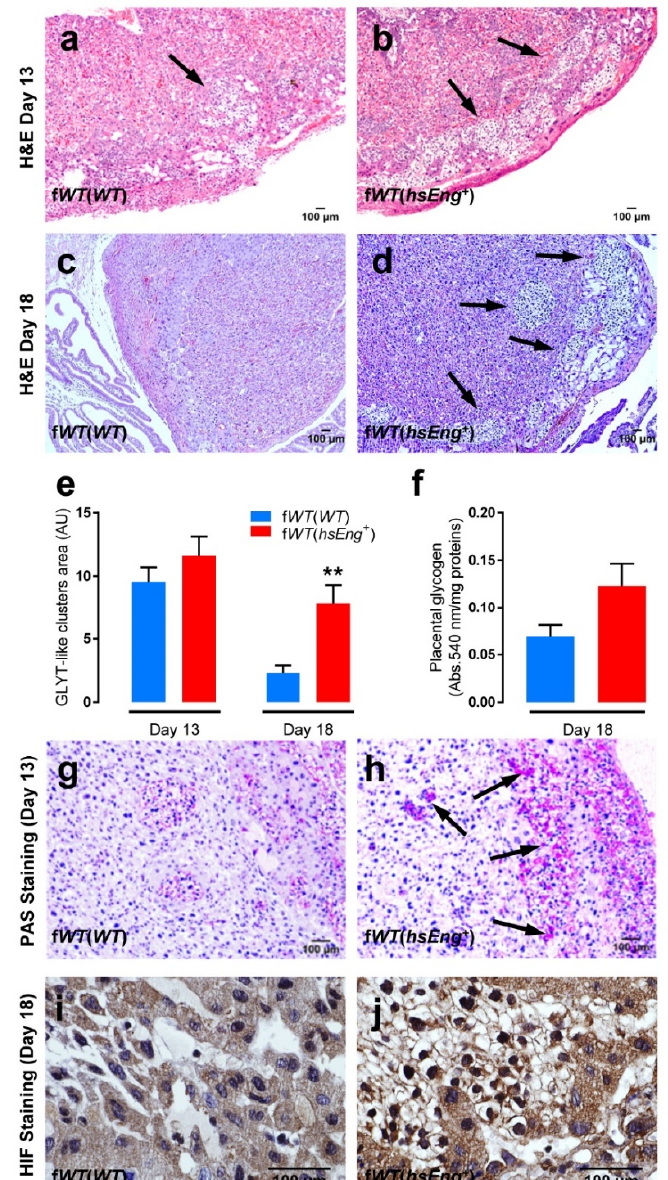
Figure 4. Histological alterations of placentas from f WT ( hsEng + ) mice. ( a – d ) Hematoxylin-eosin (H&E) staining of placentas from f WT ( WT ) and f WT ( hsEng + ) mice at Day 13 ( a , b ) and Day 18 ( c , d ) showing the presence of clusters of glycogen-containing trophoblast (GLYT)-like cells in the basal area of some placentas (arrows); ( e ) Quantification of the area occupied by GLYT-like clusters in placentas from f WT ( WT ) and f WT ( hsEng + ) mice at Day 13 (f WT ( WT ) n = 20 and f WT ( hsEng + ) n = 17) and Day 18 (f WT ( WT ) n = 13 and f WT ( hsEng + ) n = 16) of gestation; ( f ) Glycogen content in placentas from f WT ( WT ) ( n = 13) and f WT ( hsEng + ) ( n = 15) mice at Day 18 of gestation; ( g , h ) Periodic acid–Schiff (PAS) staining of placentas from f WT ( WT ) and f WT ( hsEng + ) mice at Day 18 colocalizing high levels of polysaccharides with GLYT-like clusters; ( i , j ) Immunohistochemical staining for HIF-1 α of placentas from f WT ( WT ) and f WT ( hsEng + ) mice at Day 18 showing nuclear HIF-1 α expression in GLYTs from f WT ( hsEng + ). Mean ± SEM are displayed. ** p < 0.01 of f WT ( hsEng + ) vs. f WT ( WT